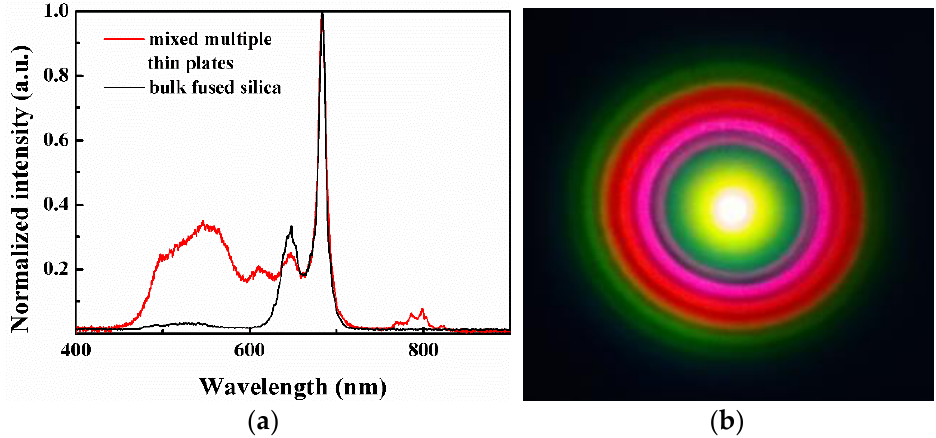
Figure 6. ( a ) SC spectra generated from the bulk fused silica and the mixed multiple thin plates. ( b ) Image of the SC beam profile in the bulk fused silica.